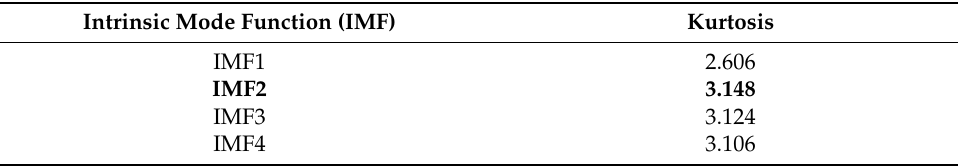
( b ) Figure 10. The extracted impact signal by proposed method: ( a ) Time domain signal; ( b ) Amplitude spectrum.